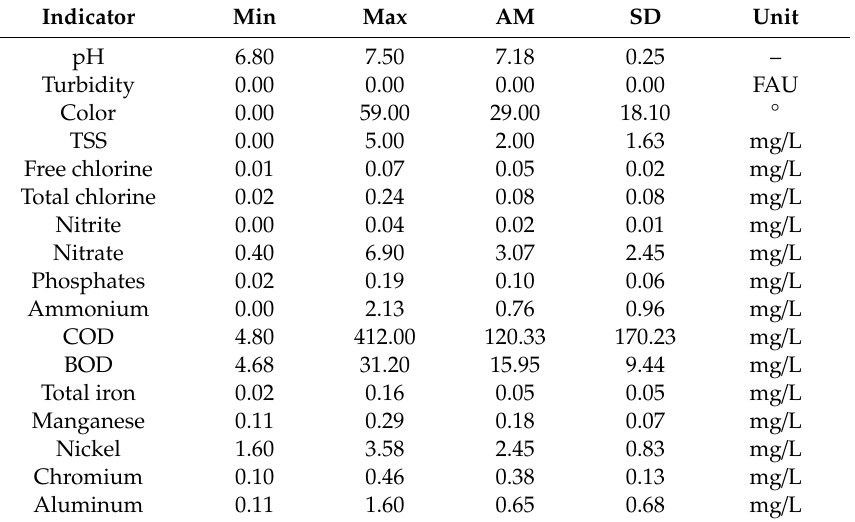
Table 6. Physicochemical results from the Al–Ti treatment